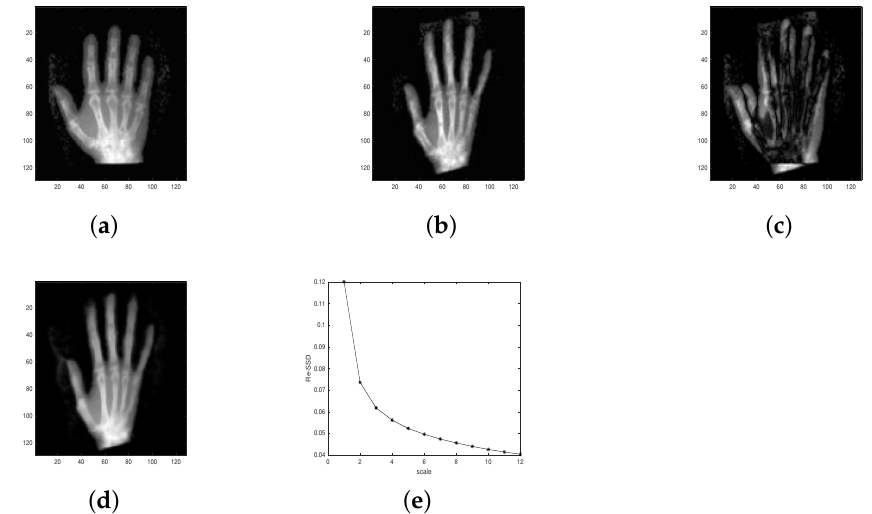
Figure 7. Registration result of Algorithm 2 on image pairs Hand. ( a ) T ( · ) . ( b ) D ( · ) . ( c ) | T − D | . ( · ) . ( e ) Re − SSD change (Hand) with scale ( d ) T ◦ ˆ h K M